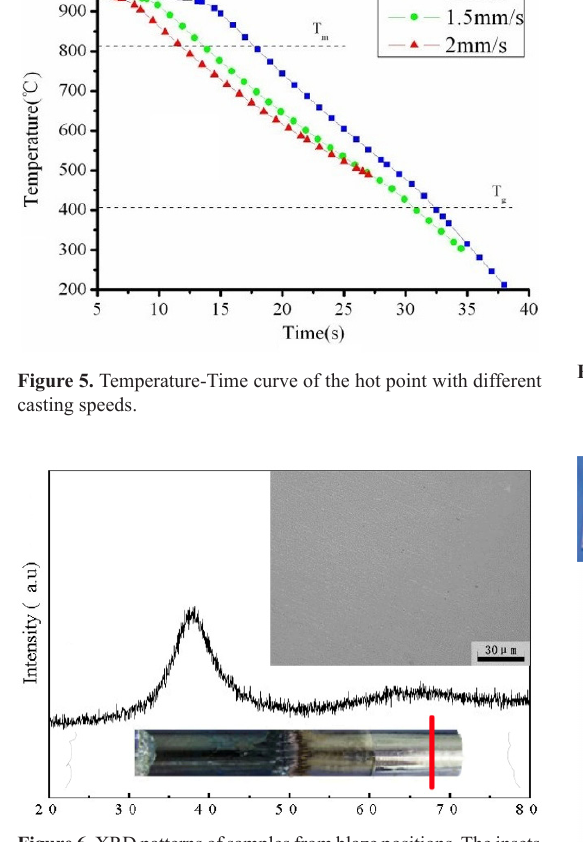
Figure 6. XRD patterns of samples from blaze positions. The insets illustrate the Zr